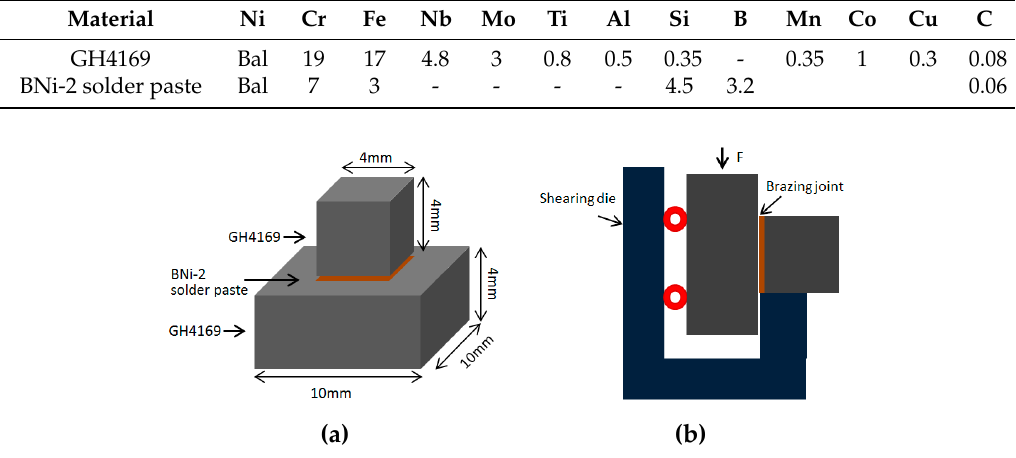
Figure 1. ( a ) Samples for microstructure observation and ( b ) a schematic illustration of fixture for the shear test.